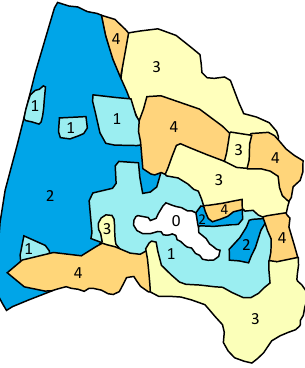
Figure 4. Groundwater recharge zones. Zone 0: Lake Hampen, Zone 1: Coniferous forest with an unsaturated zone thickness less than 5 m, Zone 2: Grass with an unsaturated zone thickness less than 5 m, Zone 3: Forest with an unsaturated zone thickness larger than 5 m, Zone 4: Grass with an unsaturated zone thickness larger than 5 m.